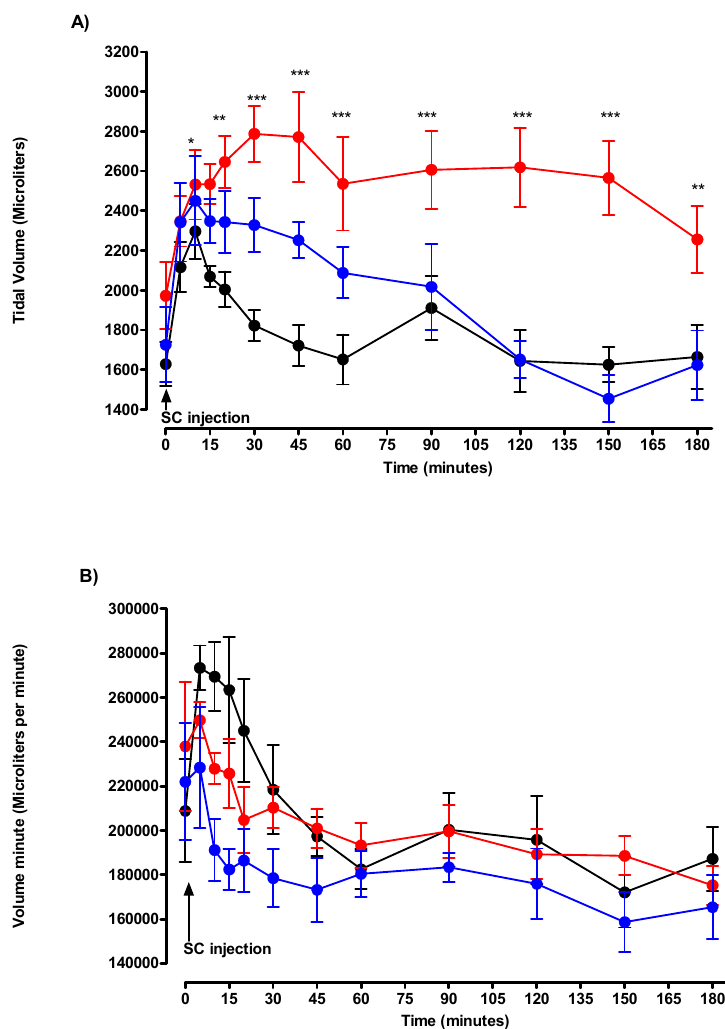
Figure 5. Effects of solvent (black circle), DMPO 50% MLD50 (blue circle), and DEPO 50% MLD50 (red circle) on the ( A ) tidal volume and the ( B ) volume minute. Arrow denotes the time of injection of solvent, DMPO, or DEPO. Each group consisted of six rats. Data are represented by mean ± SEM at each time after injection. DMPO vs. control: + p < 0.05, ++ p < 0.01, and +++ p < 0.001. DEPO vs. control: * p < 0.05, ** p < 0.01, and *** p < 0.001.